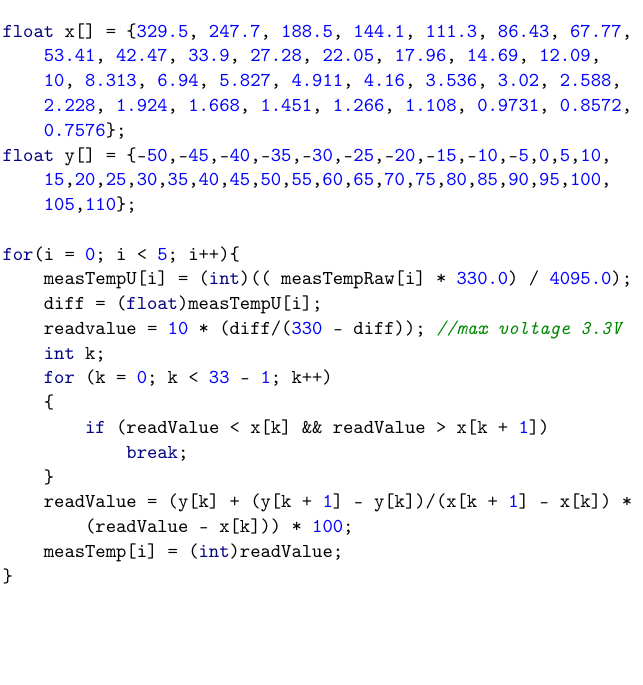
Figure 9. The measured temperature according to real temperature in the smart IoT device. Listing 1. Program code snippet for temperature interpolation.